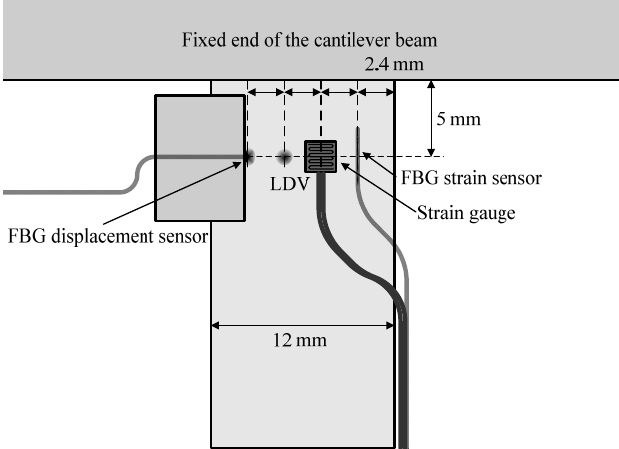
Figure 6. Illustration of locations of the sensors on the cantilever